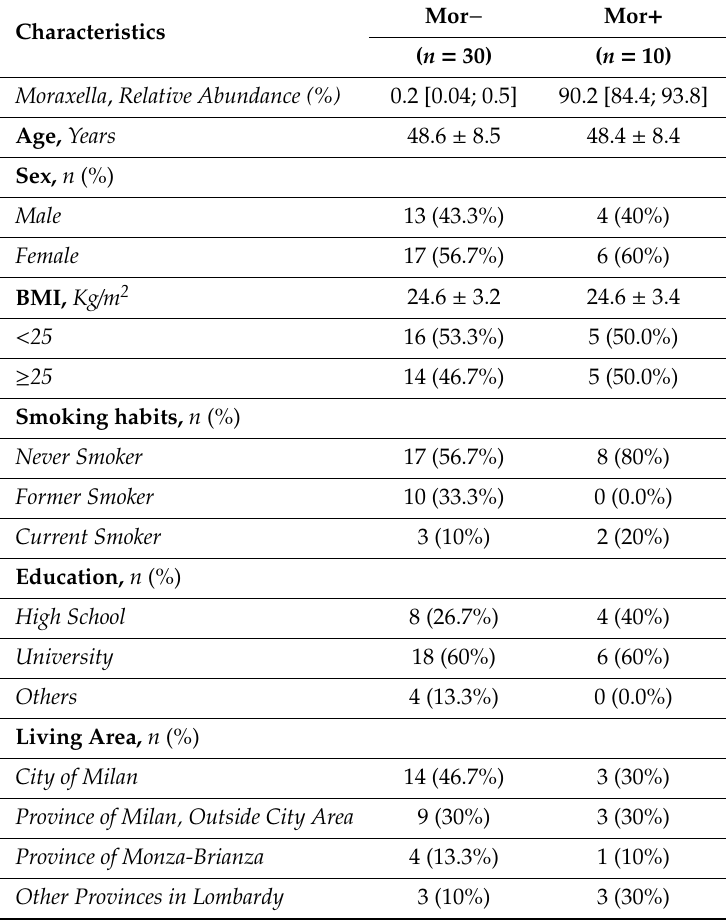
Table 1. Characteristics of the study participants in the Mor − and Mor + groups.